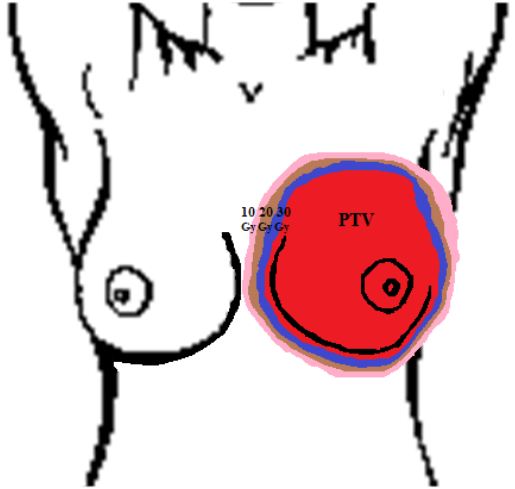
Figure 1. Exemplary isodose drawing scheme generated from the individual treatment plan for each patient — PTV area (red), 30 Gy (navy blue), 20 Gy (brown) and 10 Gy (pink).